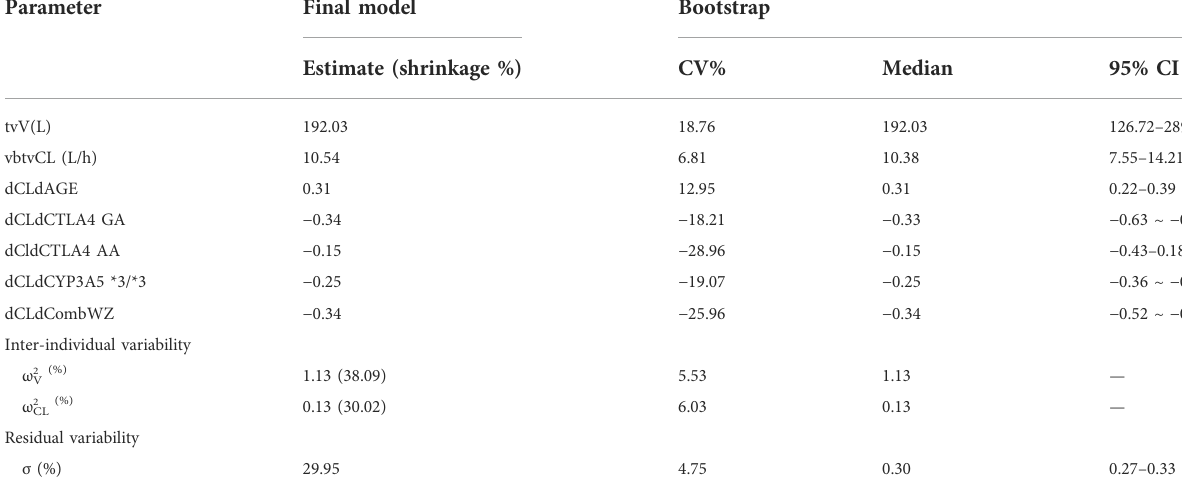
TABLE 3 Parameter estimation results and bootstrap results of the fi nal population pharmacokinetic